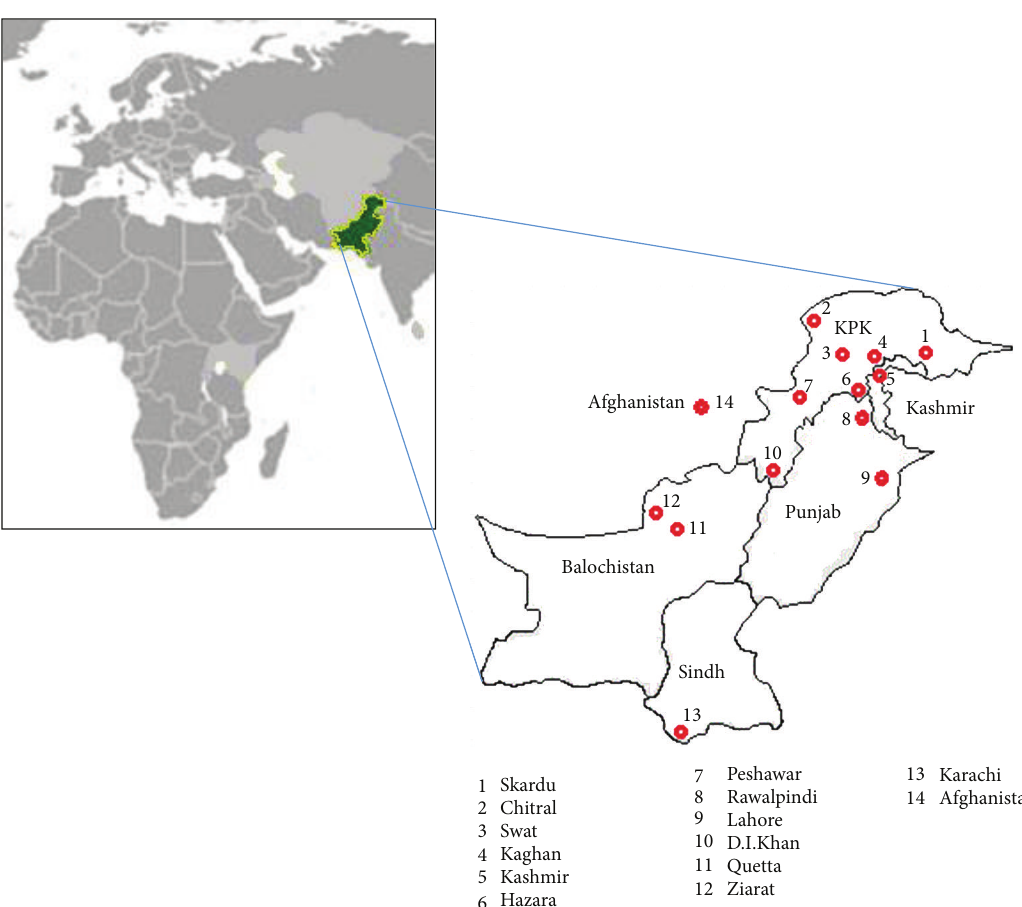
Figure 1: Map showing the areas of distribution of medicinal plants in Pakistan used in the present